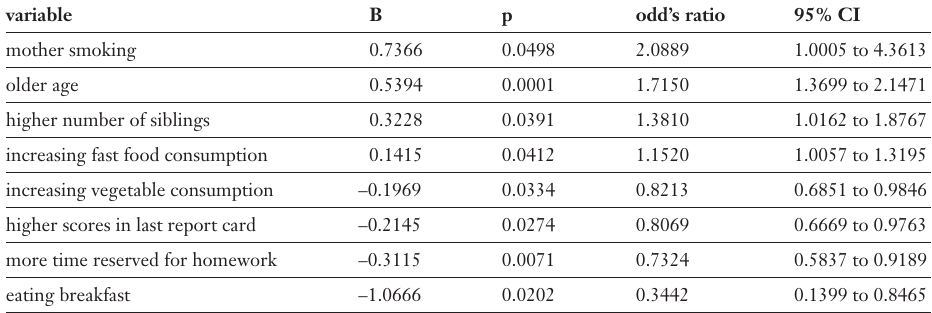
Factors associated with smoking. Vari- ables included in the model: age, sex, socioeconomic status, daily studying time, grade status in last report card, living with family, nutritional behav- iour (consumption of vegetable, fruit, meat and fast food; breakfasting), mother’s and father’s smoking status, time spent watching television, num- ber of siblings, family type, separation of parents and self esteem. Sex, fam- ily type, separaton of parents, parental smoking status, having breakfast and living conditions (with family vs other) have been used as categorical variables. Other variables have been entered as continuous